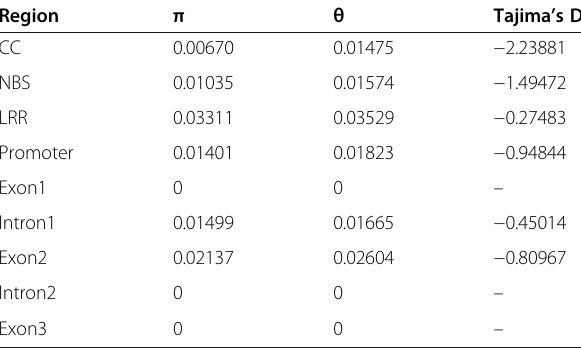
Table 2 Summary of the natural variation of different Pi9 allele genes in different species Region